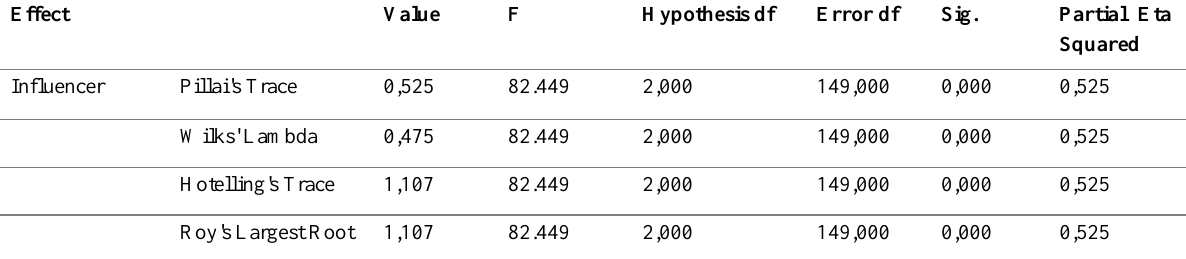
Table 5: Multivariate Tests